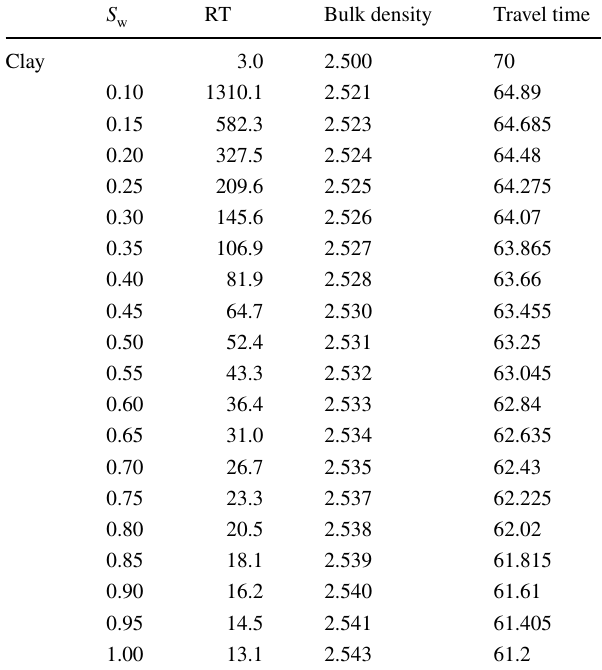
Table 2 Rock responses